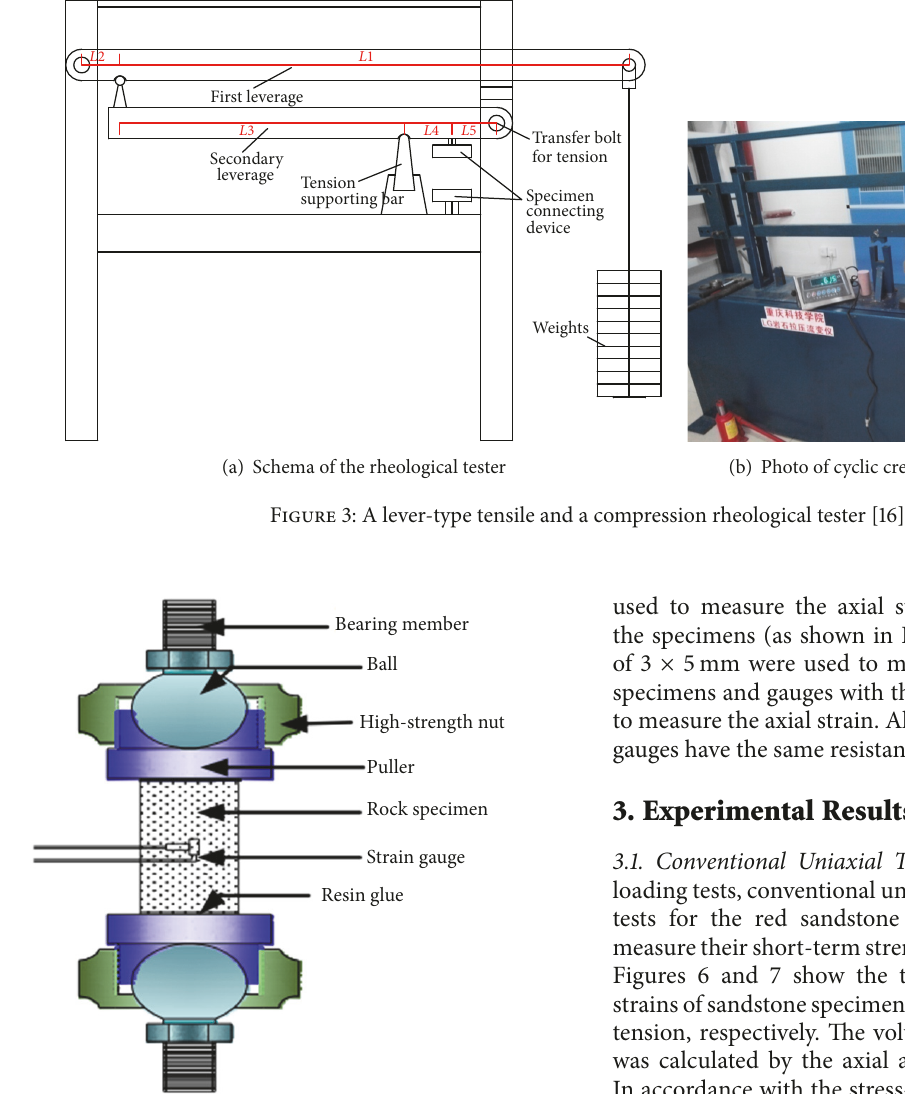
Figure 4: Specimen holding device